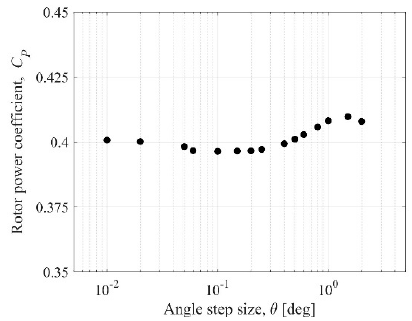
Figure 17. Influence of the time step size (the angle step size Δθ ) on the rotor power coefficient.